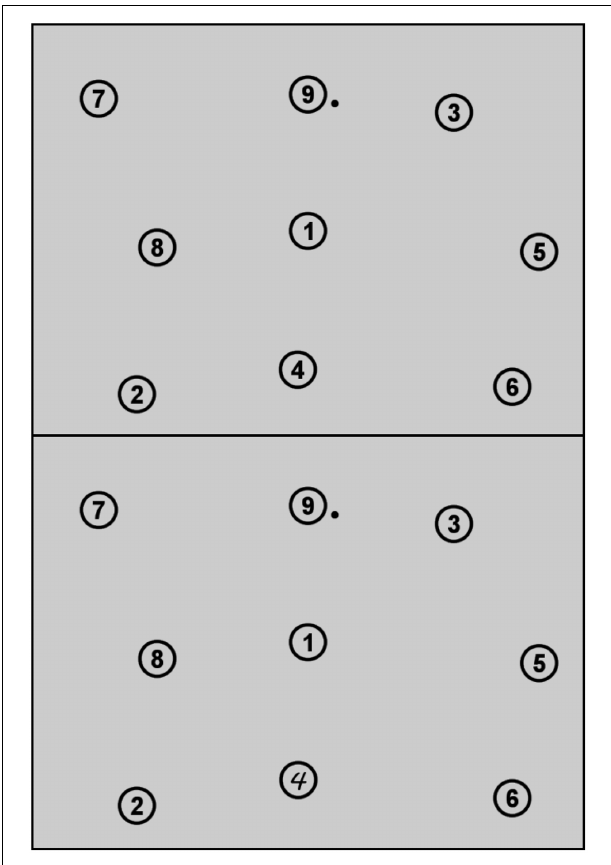
FIGURE 1 | Display during the clicking task in the prechange (top), the change (bottom), and the reversion (top) phase. The black dot near number nine displays the mouse